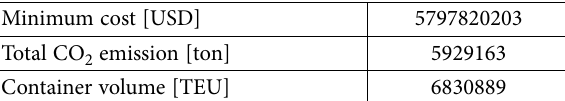
Table 6. Part of computing results